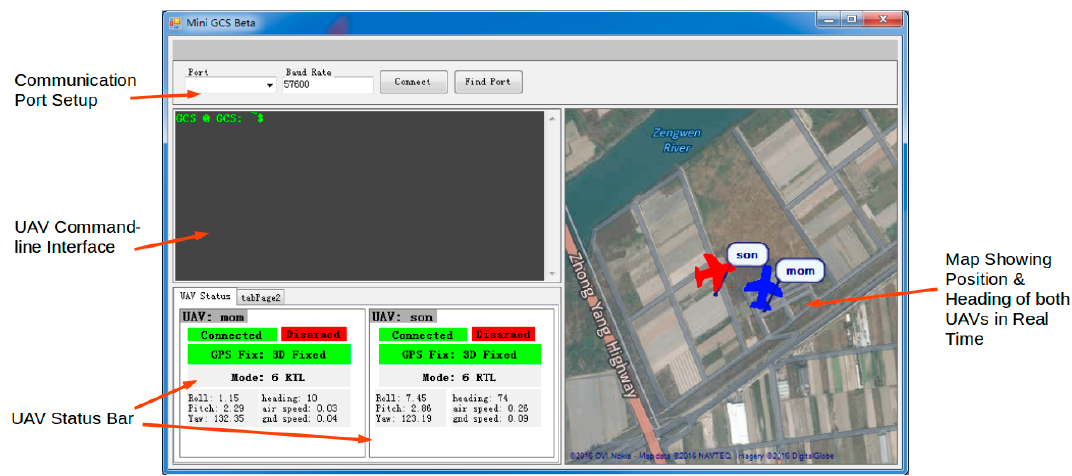
Figure 13. Graphic user interface (GUI) of Mini GCS.